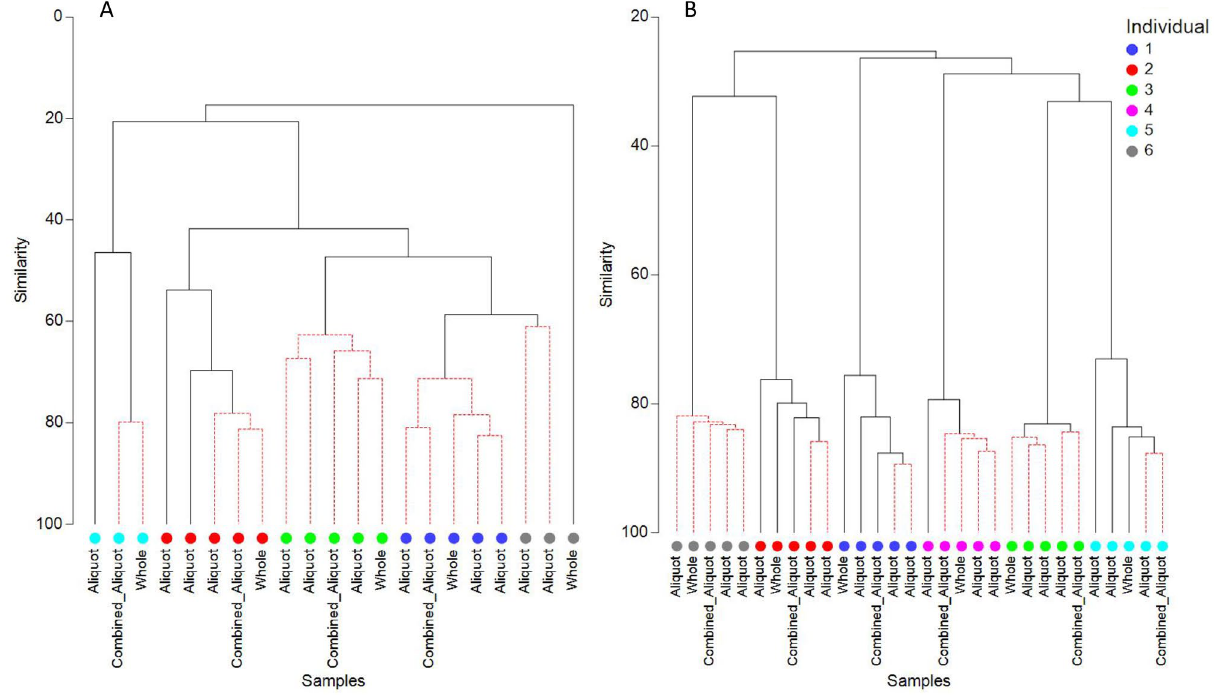
Figure 2. Clustering mycobiome ( A ), and bacteriome ( B ) from whole stool, aliquot, and combined aliquot sampling methods. A SIMPROF test with alpha = 0.05 was used to determine significantly similar sub groupings within individuals, with red dashed lines grouping samples which are significantly similar, and solid black likes grouping samples which are not significantly similar. Group average cluster analysis (9999 repeats) on Bray– Curtis